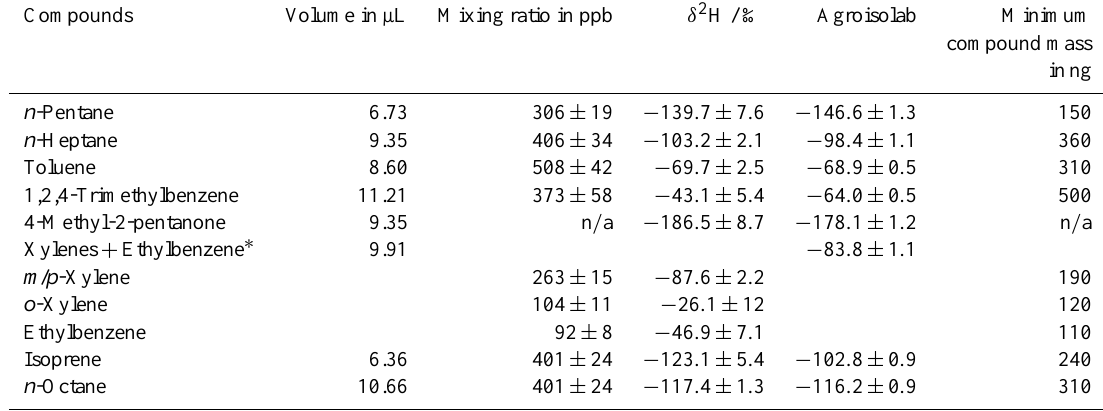
Table 1. Compounds contained in the VOC test mixture, volumes of the liquids injected into the gas cylinder and final mixing ratios. For comparison the hydrogen isotope ratios and standard deviations obtained by our GC-P-IRMS as well as the results of EA (Agroisolab) of the pure liquids are shown. Furthermore, the minimum compound mass to yield stable isotope ratios is given in ng.